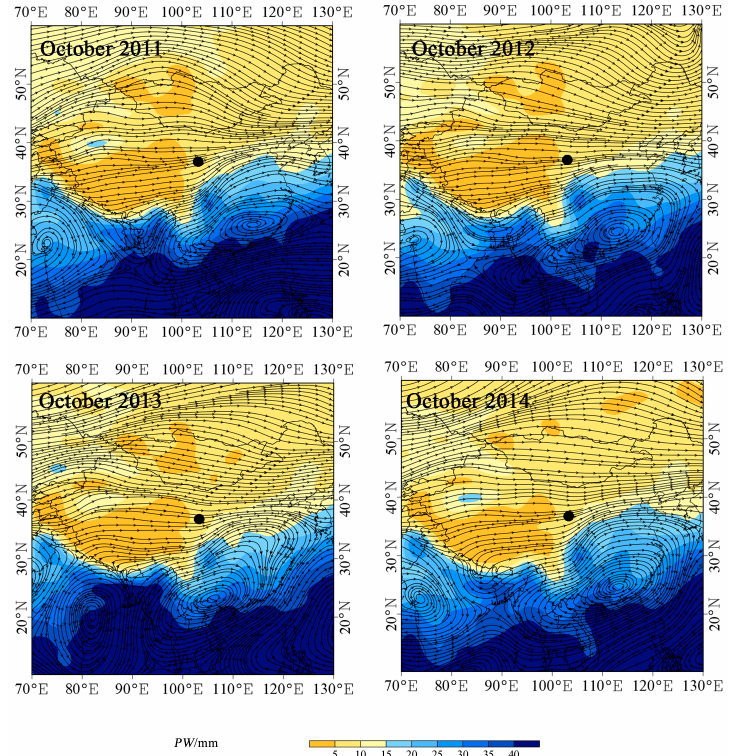
Figure 9. Water vapor stream and precipitable water amount ( PW ) surrounding the study region in October for different years.